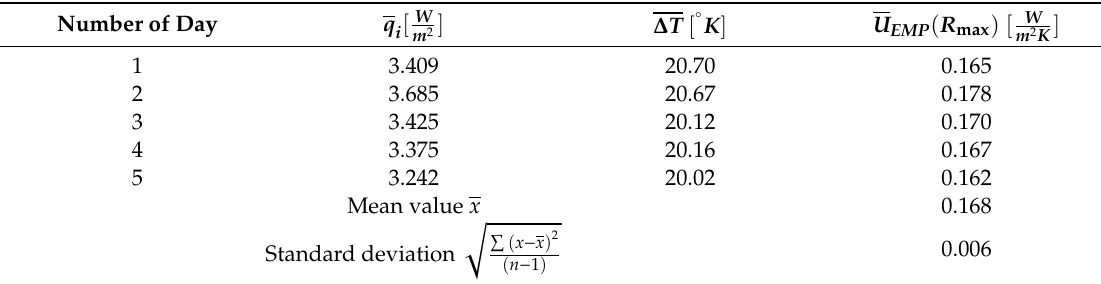
Table 2. Averaged daily values of heat flux density, outdoor temperature and empirically determined heat transfer coe ffi